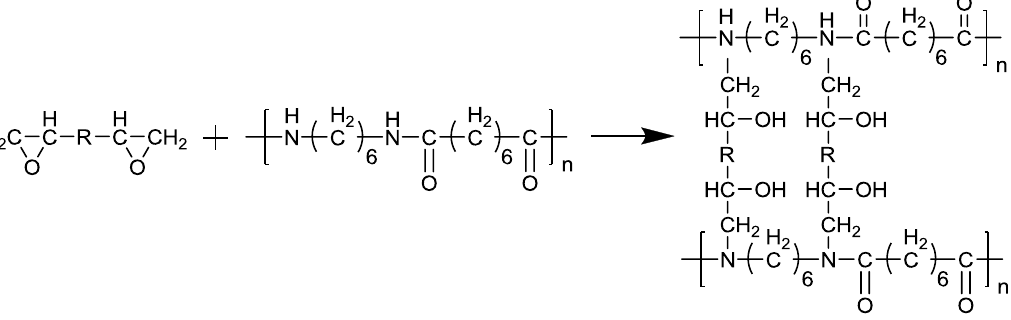
Figure 2. The crosslink reaction formula of nylon 66 and liquid crystalline epoxy.